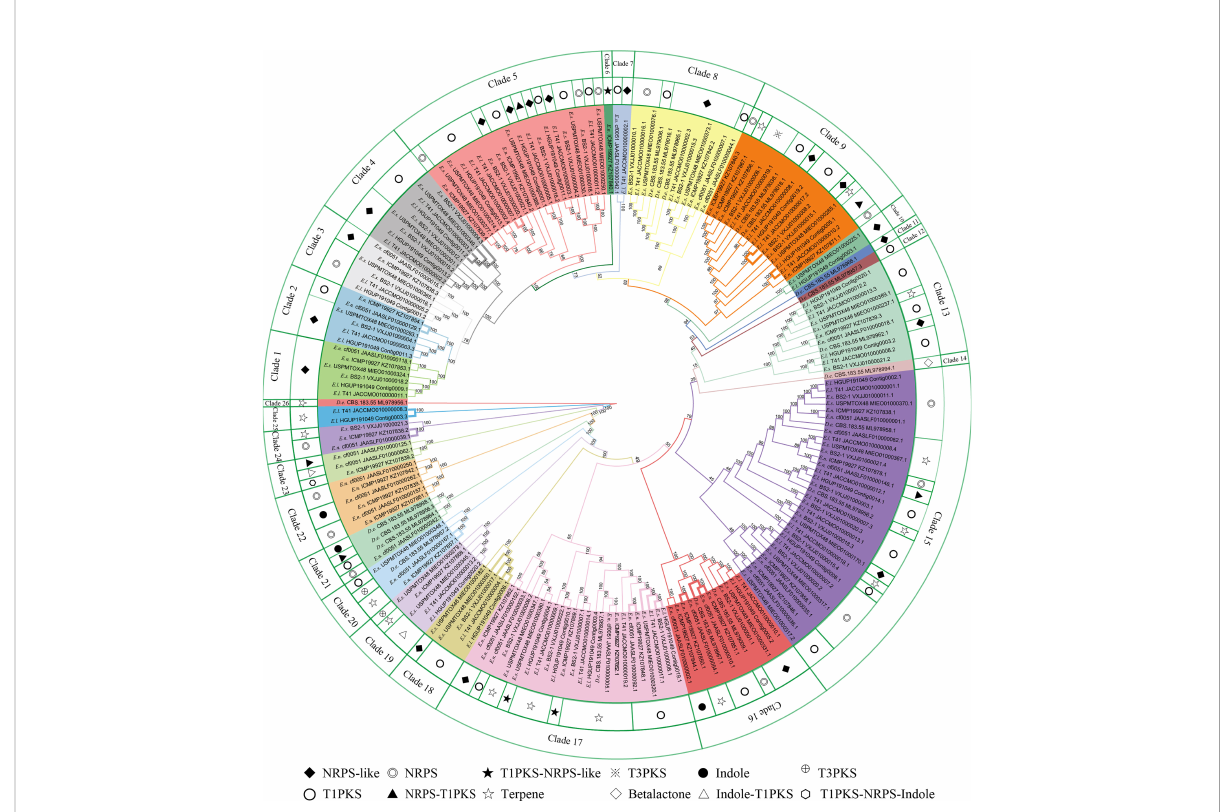
FIGURE 10 Phylogenetic analyses of biosynthetic gene clusters (BGCs). Bootstrap support values for maximum likelihood are given near nodes. D.e , Didymella exigua ; E.l , Epicoccum latusicollum ; E.n , Epicoccum nigrum ; E.s , Epicoccum sorghinum. The species name is followed by the strain number, and the fi nal number indicates the gene of each BGC. Bolded adjacent branches indicate coding for the same